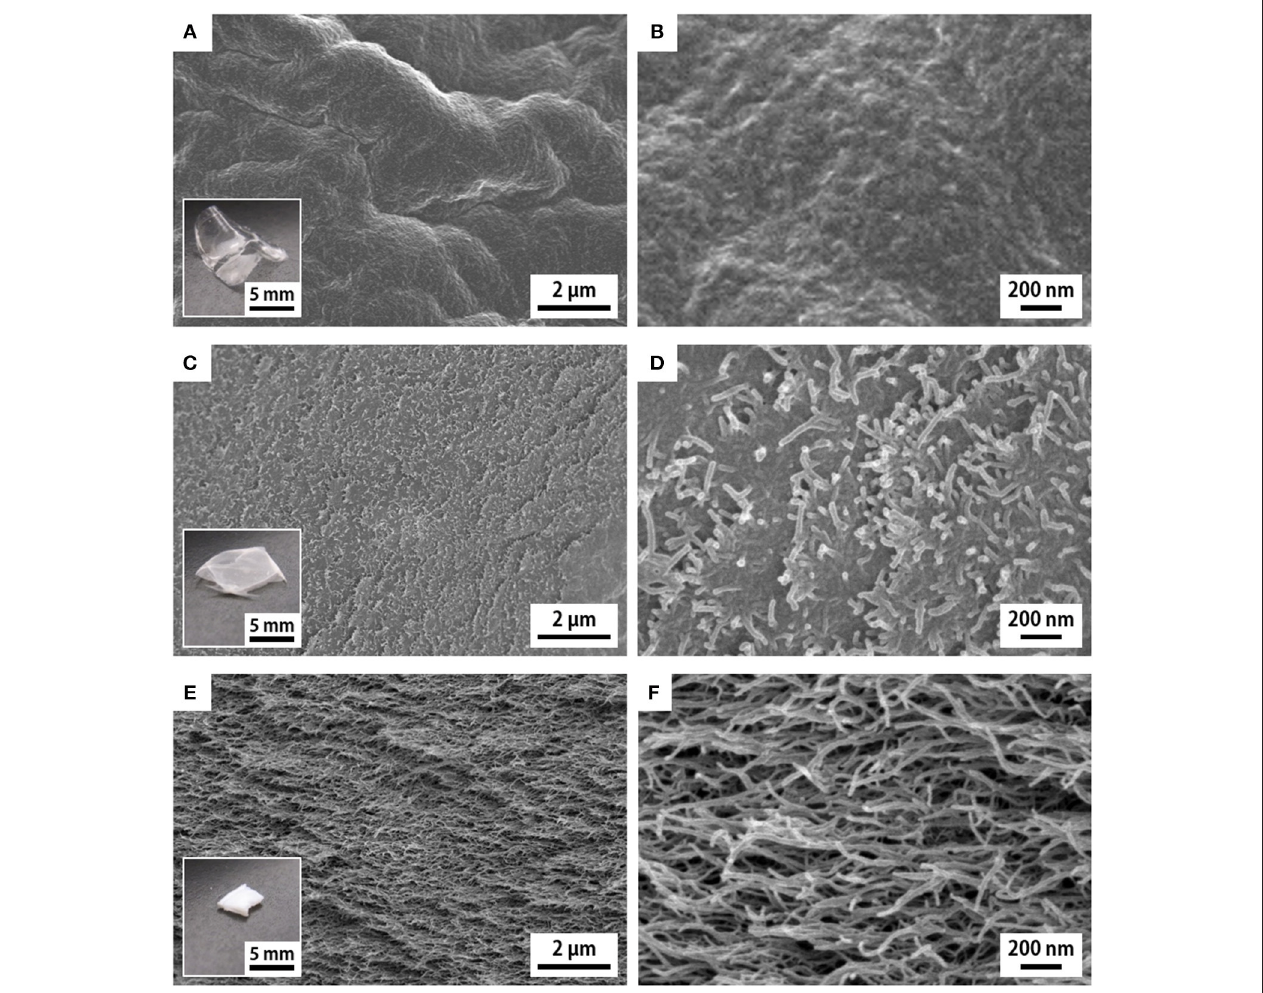
FIGURE 1 | SEM images of the cross sections of the (A,B) w -xerogel, (C,D) a -xerogel, and (E,F) h -xerogel. Insets show the appearances of the respective xerogels.